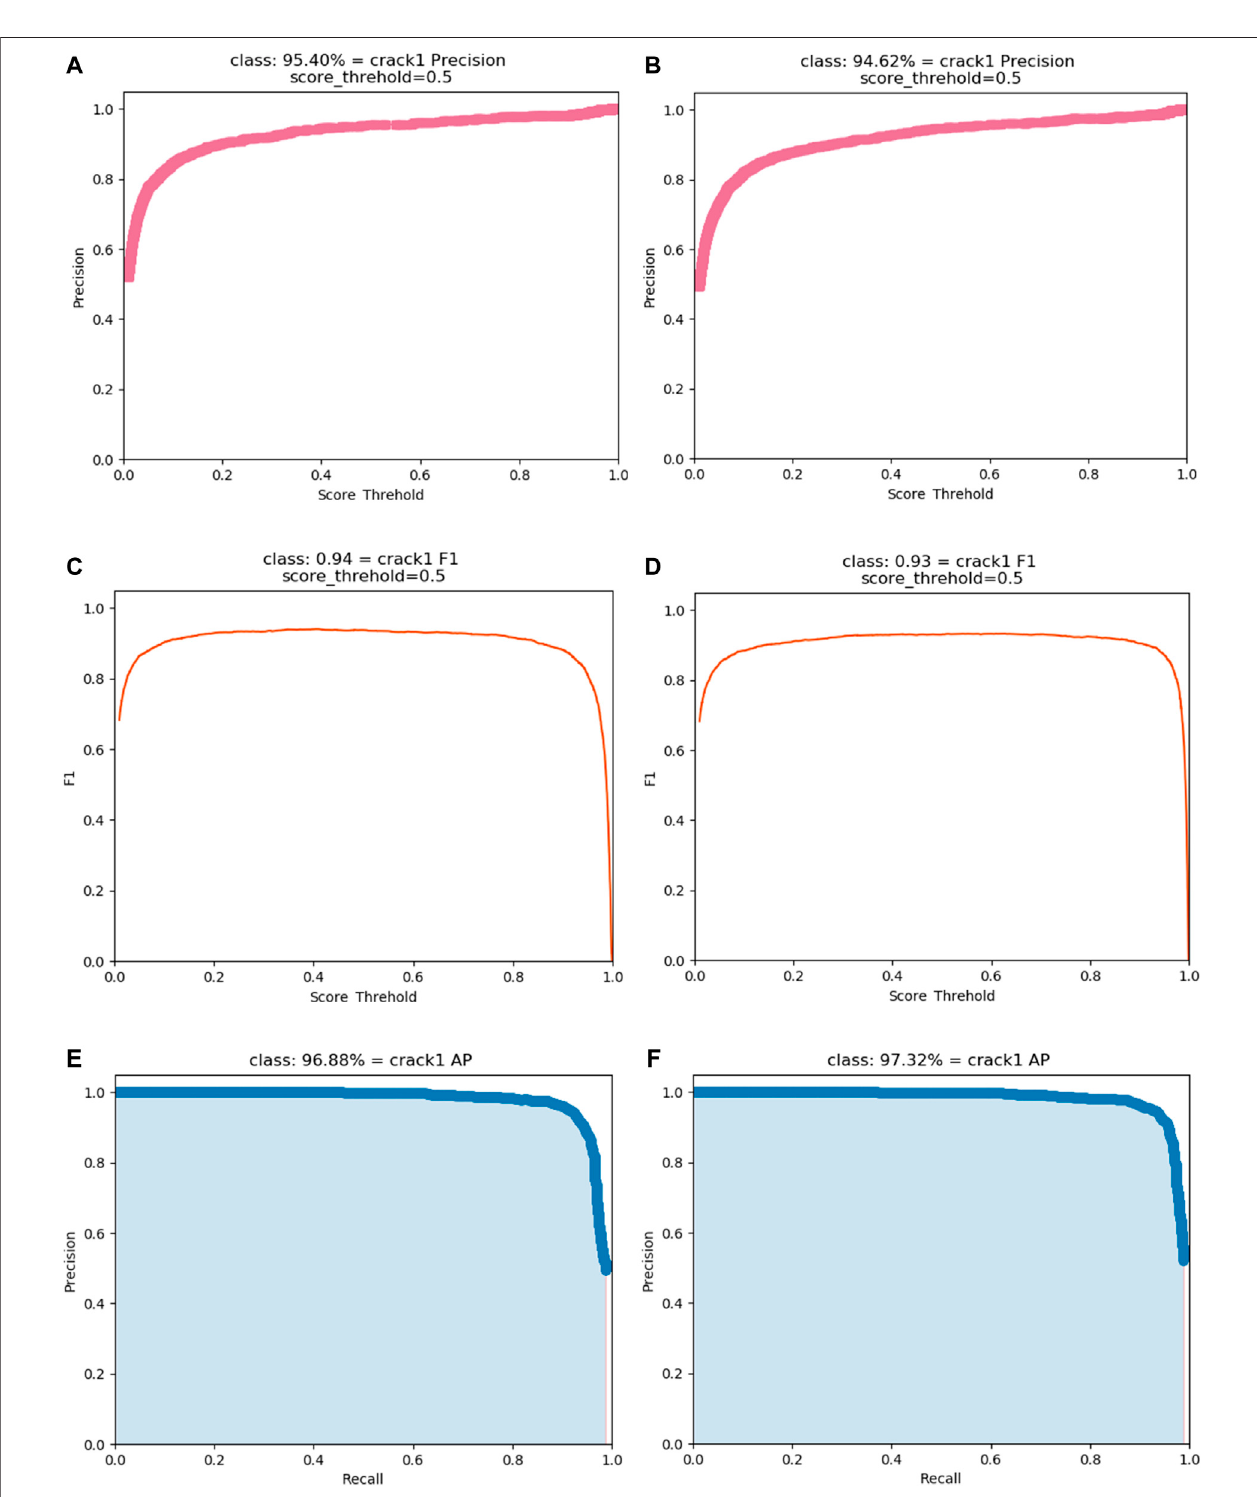
FIGURE 10 | The indices of the original YOLOv4 model and the lightweight YOLOv4 model: (A) Precision of the original YOLOv4 model (B) Precision of the lightweight YOLOv4 model (C) F 1 of the original YOLOv4 model (D) F 1 of the lightweight YOLOv4 model (E) AP of the original YOLOv4 model (F) AP of the lightweight YOLOv4